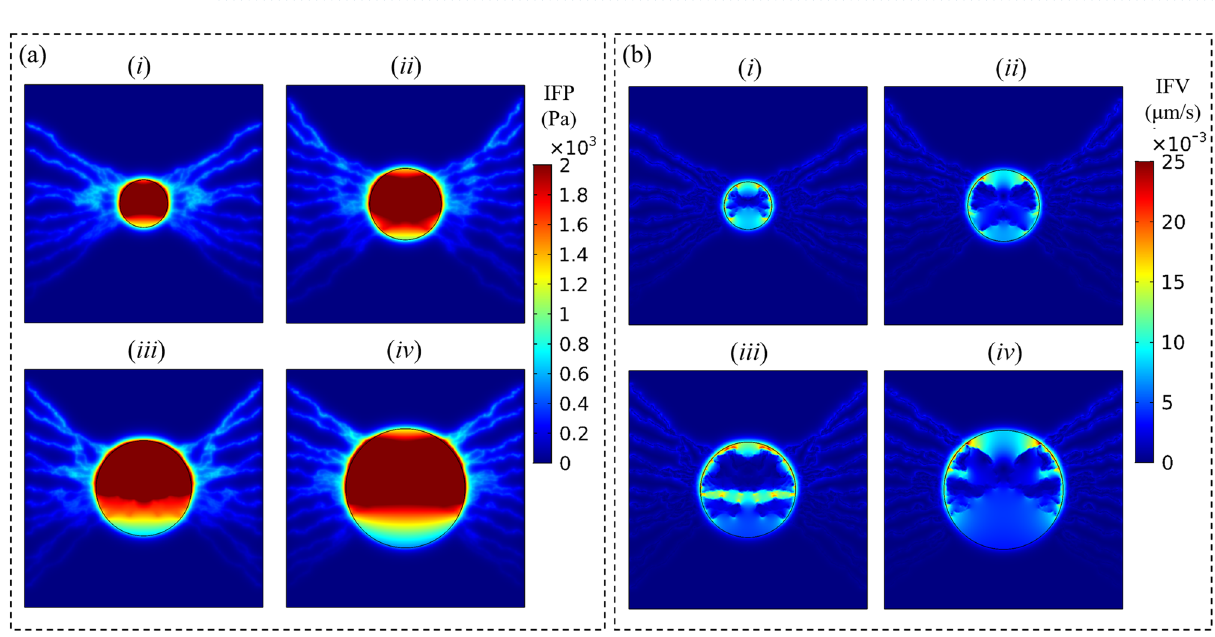
Figure 5. Interstitial fluid fields. ( a ) IFP and ( b ) IFV for tumors with ( i ) 1 cm, ( ii ) 1.5 cm, ( iii ) 2 cm, and ( iv ) 2.5 cm